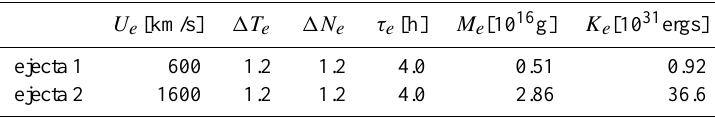
Table 4. Two-dimensional simulation. Characteristics of the ejecta-like pulses: initial velocity, increment of density and temperature, temporal duration, total mass and total kinetic energy as defined in Table 2.